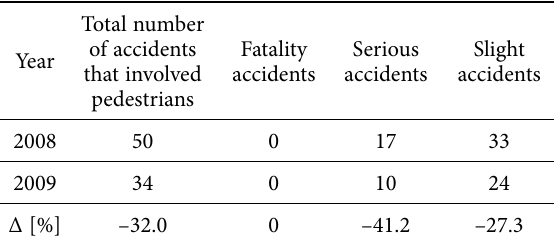
Table 5. The number and consequences of traffic accidents for the period 2008–2009 (http://www.mup.rs –